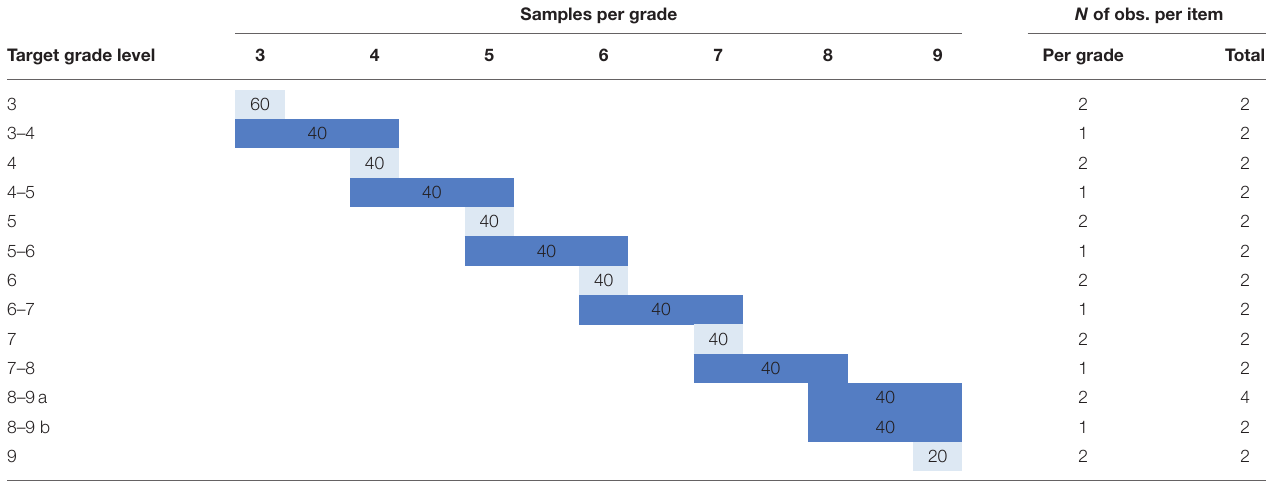
TABLE 2 | Macro-level common item design. Samples per grade N of obs. per